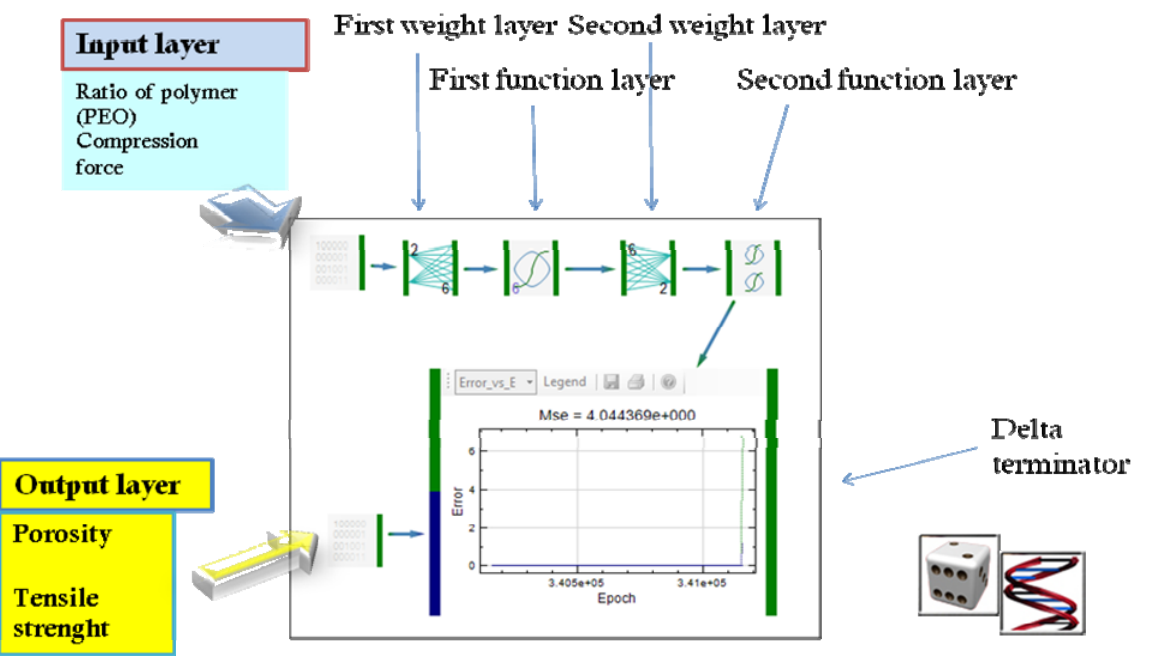
Figure 9. Schematic representation of MLP